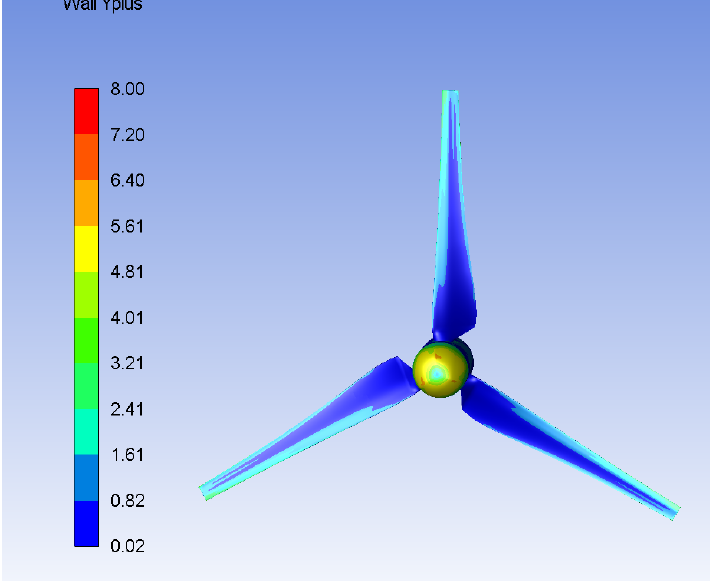
Figure 6. Contour of the wall y + .